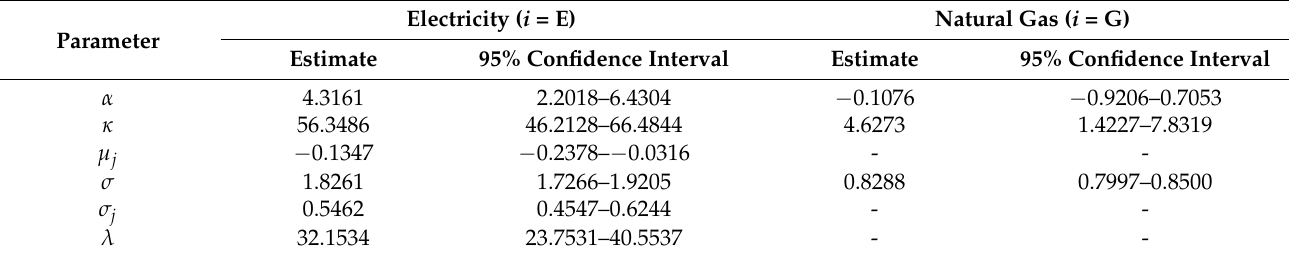
Table 3. Stochastic electricity